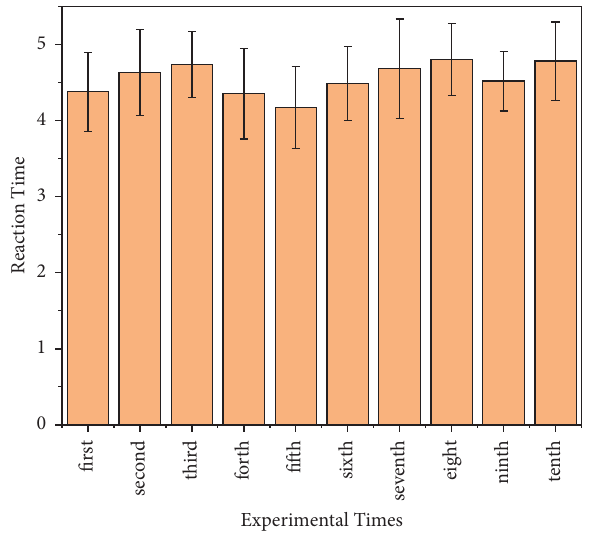
Figure 12: Ten repetitions’ reaction time of ten